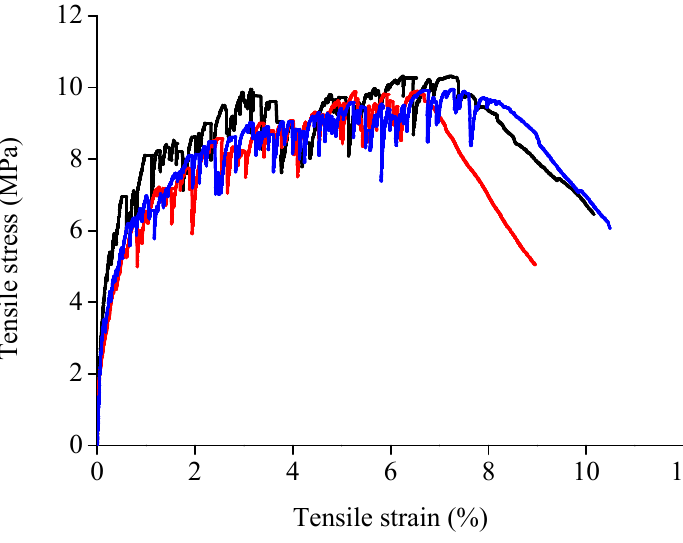
Figure 1. Measured tensile stress-stain curves of ECC.